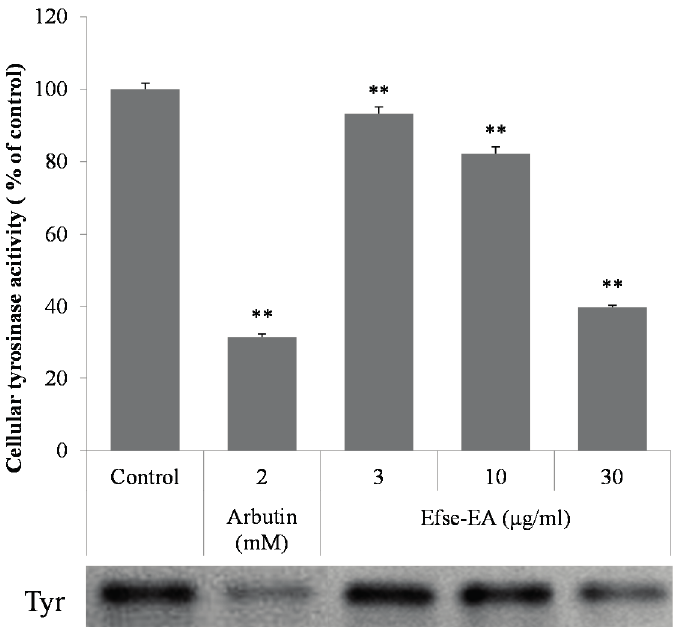
Figure 4. Effect of Efse-EA on intracellular tyrosinase activity. Melan-a cells (1 × 10 5 cells/mL) were cultured for 24 h; the medium was replaced with fresh medium containing the indicated concentrations of Efse-EA or arbutin for 3 days. The cells were collected and lysed. After quantifying protein levels, tyrosinase activity was determined by L -DOPA zymography. Each determination was made in triplicate and the data shown represent the mean ± SD. ** p < 0.01, Student’s t